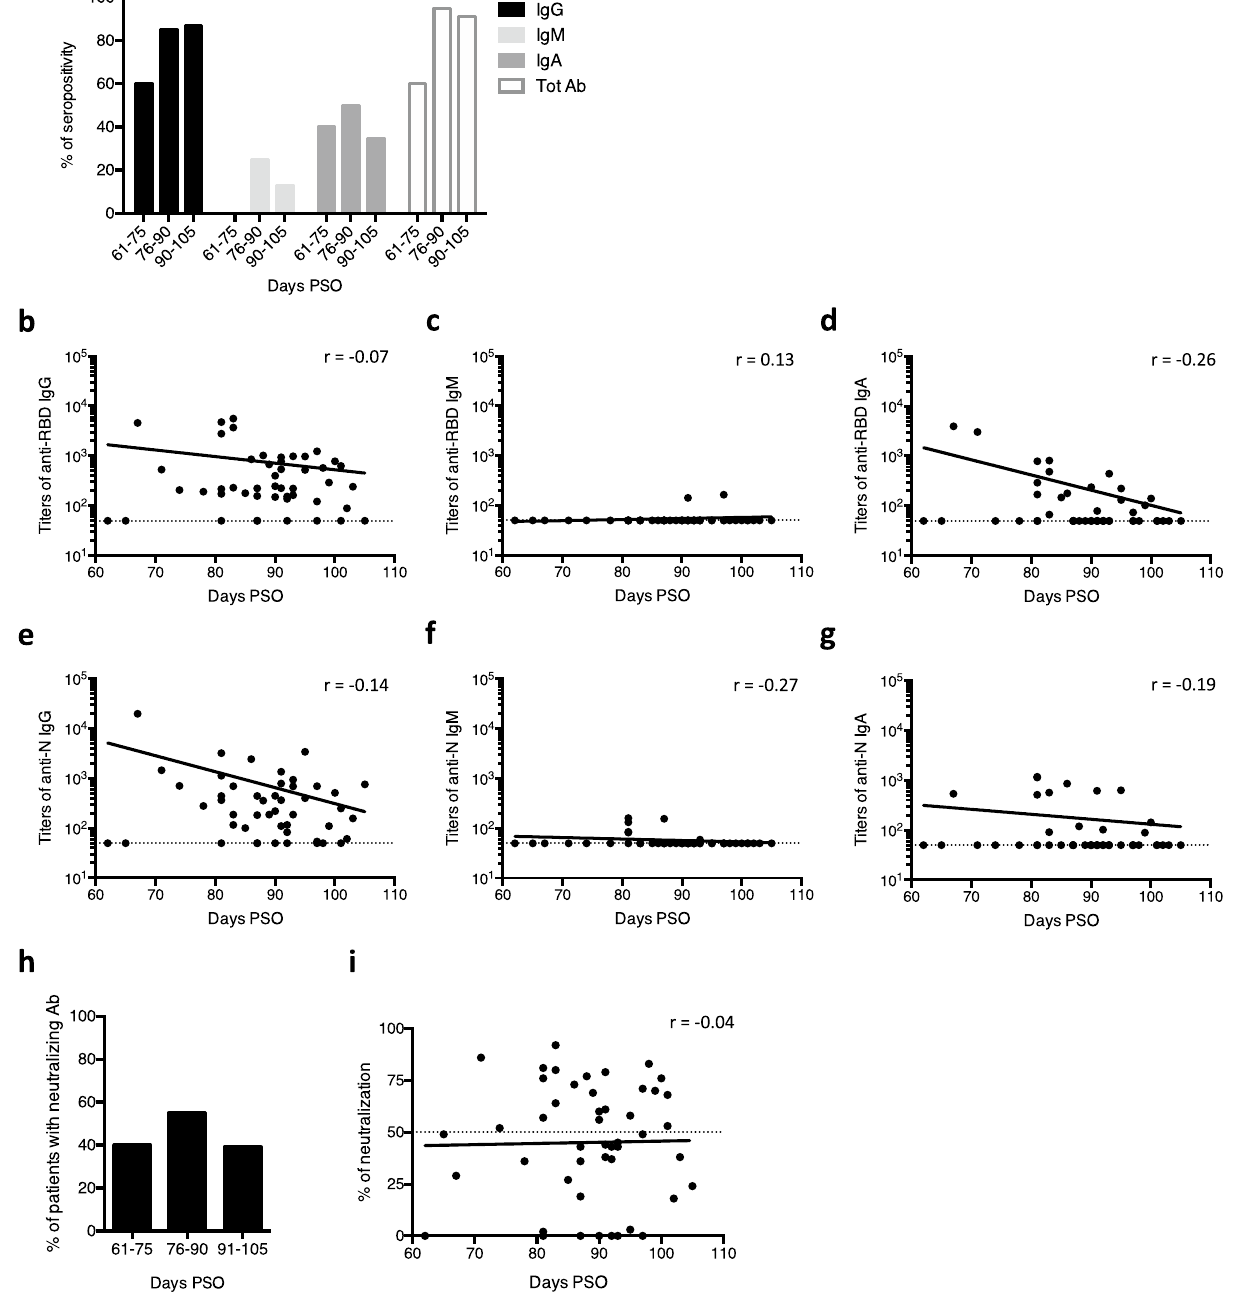
Figure 4. Kinetics of antibody responses against SARS-CoV-2 in recovered COVID-19 patients. Recovered COVID-19 patients were individuals infected by SARS-CoV2 more than 2 months ago who were cured. ( a , h ) Percentage of seropositivity ( a ) and percentage of patients with neutralizing antibodies ( h ) in recovered patients according to the time between symptom onset and sample collection. Seropositivity corresponds to the presence of anti-RBD and/or anti-N antibodies in serum/plasma. The number of patients in each group is shown in Table 1. ( b – g , i ) Titers of anti-RBD IgG ( b ), IgM ( c ) and IgA ( d ), titers of anti-N IgG ( e ), IgM ( f ) and IgA ( g ) and spike-pseudotyped lentiviral neutralization ( i ) in recovered patients according to the time between symptom onset and sample collection. Each dot represents one sample. Dashed line represents the positivity threshold. The preferred model for best fit curve (solid line) was assessed by an extra sum-of-squares F test and is a semi- log line. The Spearman’s correlation coefficient (r) is not significant for all